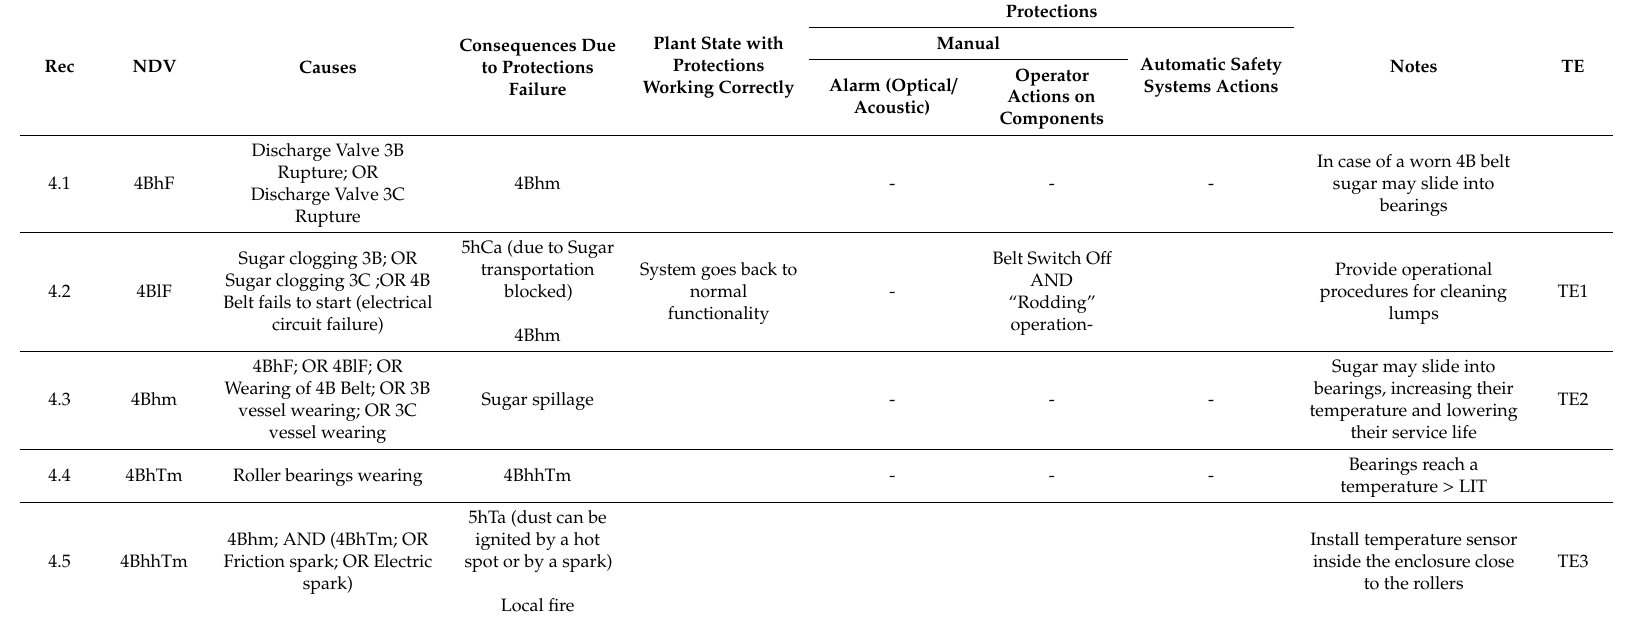
Table A1. ROA for the enclosed steel belt conveyor (Node